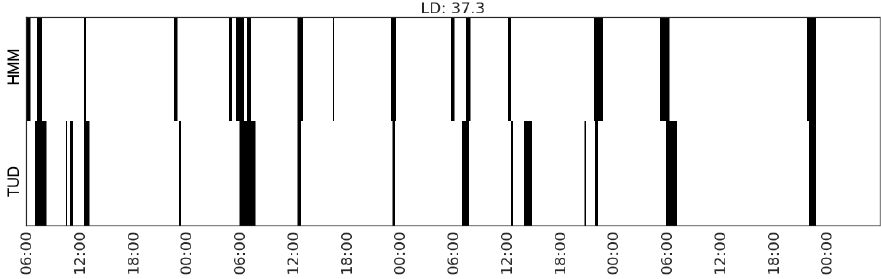
Figure 15. Recognising the activity of listening to radio in Household 2 with feature set (CP_range_hallway, MS_watts_kitchen-appliances, MS_range_bedroom).